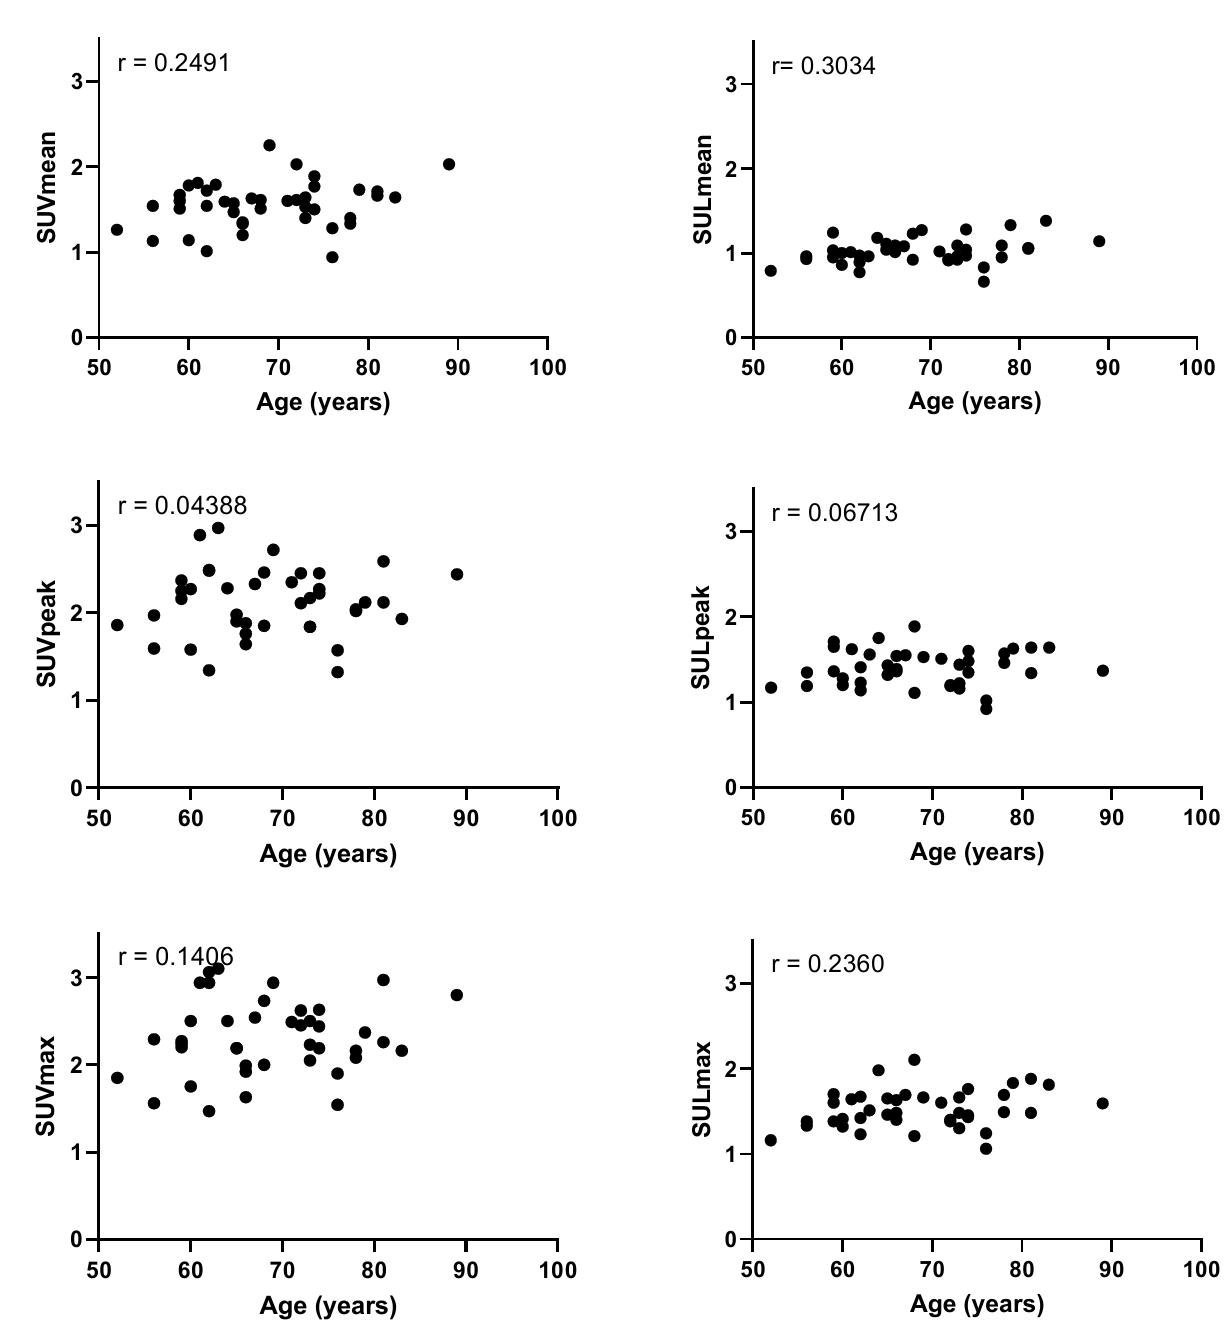
Figure 3. Plots of the patients’ ages in years and blood pool activity as measured by the mean standardized uptake value (SUV mean ), peak standardized uptake value (SUV peak ), maximum standardized uptake value (SUV max ), mean standardized uptake value corrected for lean body mass (SUL mean ), peak standardized uptake value corrected for lean body mass (SUL peak ), and maximum standardized uptake value corrected for lean body mass (SUL max ). Pearson’s r values are shown in the upper left corners. None of the correlations were statistically significant ( p = 0.582, p = 0.785, p = 1.000, p = 0.323, p = 1.000, p = 0.550 for SUV mean , SUV peak , SUV max , SUL mean , SUL peak , SUL max , respectively).